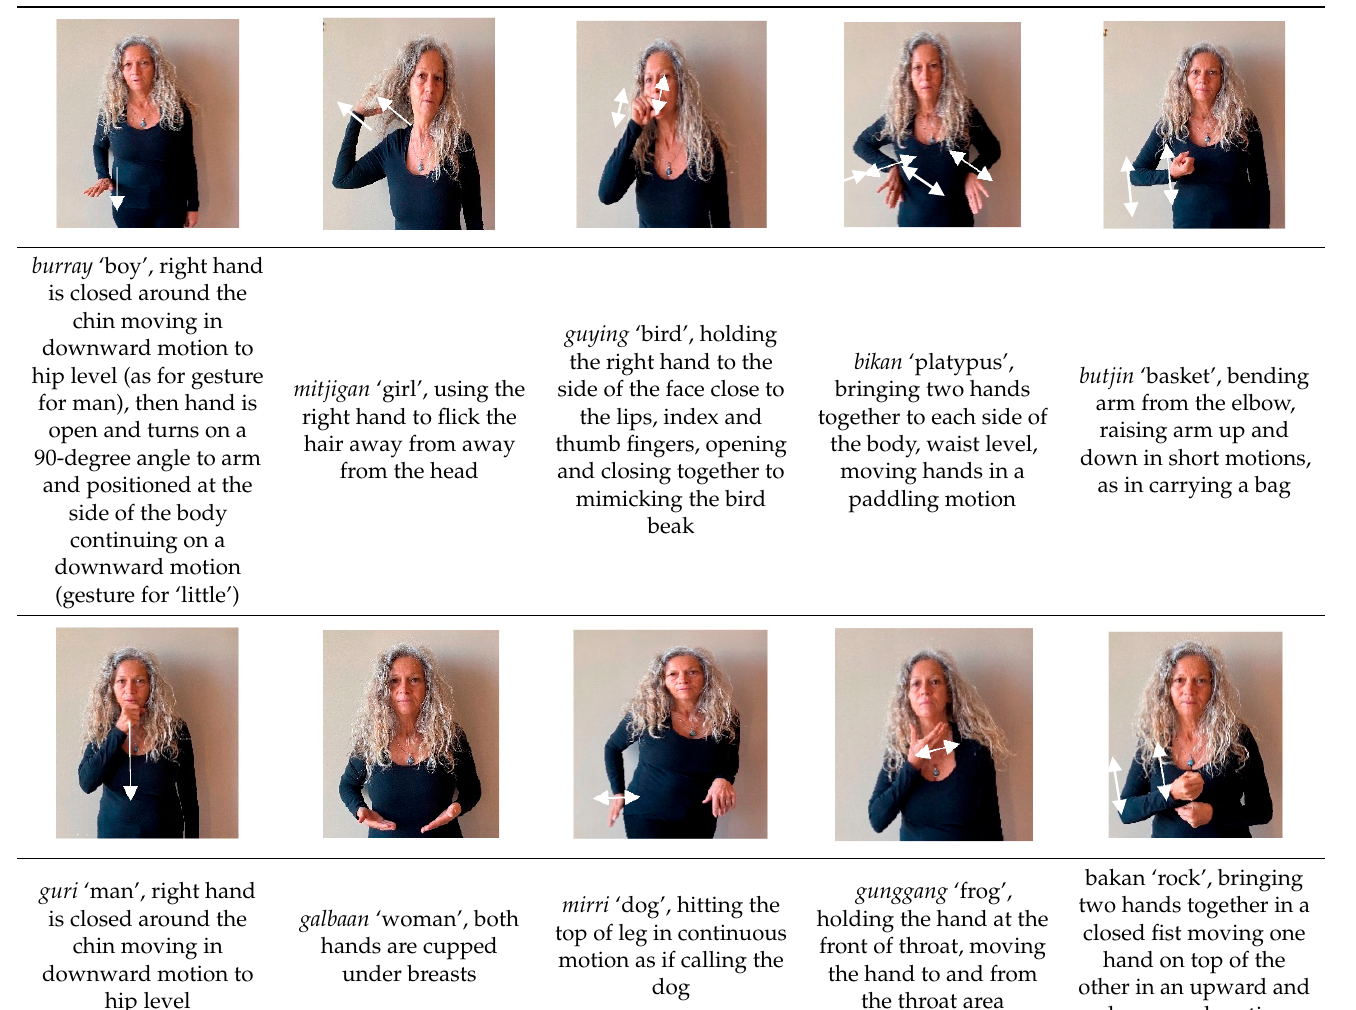
Table A1. Iconic gestures used in the study.